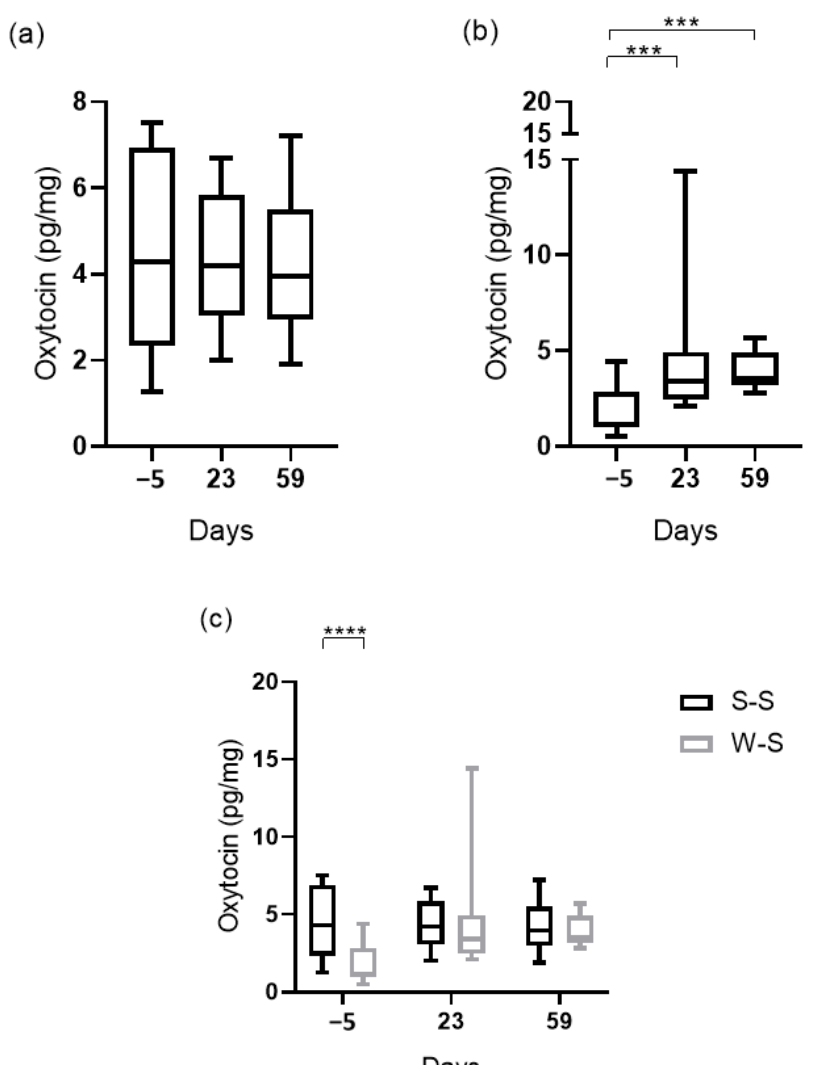
Figure 2. Oxytocin concentrations (pg/mg) in hair samples of sows at 5 days before farrowing ( − 5), 23 days after farrowing (23), and 59 days after farrowing (59) in spring–summer ( n = 10) ( a ); winter– spring ( n = 10) ( b ); and in both periods (S–S, spring–summer; W–S, winter–spring) on the same sampling day per period ( c ). Asterisks indicate significant differences (**** p < 0.0001; *** p < 0.001). Plots show median (line within box), 25th and 75th percentiles (box) and minimum and maximum values